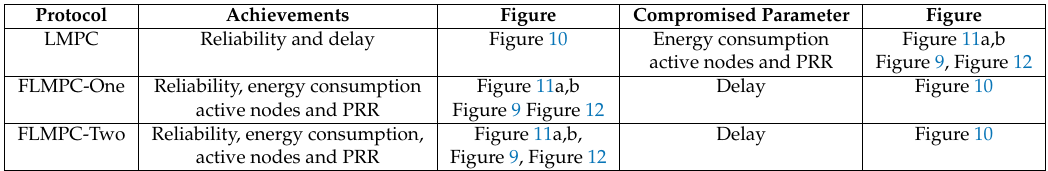
Table 5. Performance Tradeoffs in Proposed and Compared